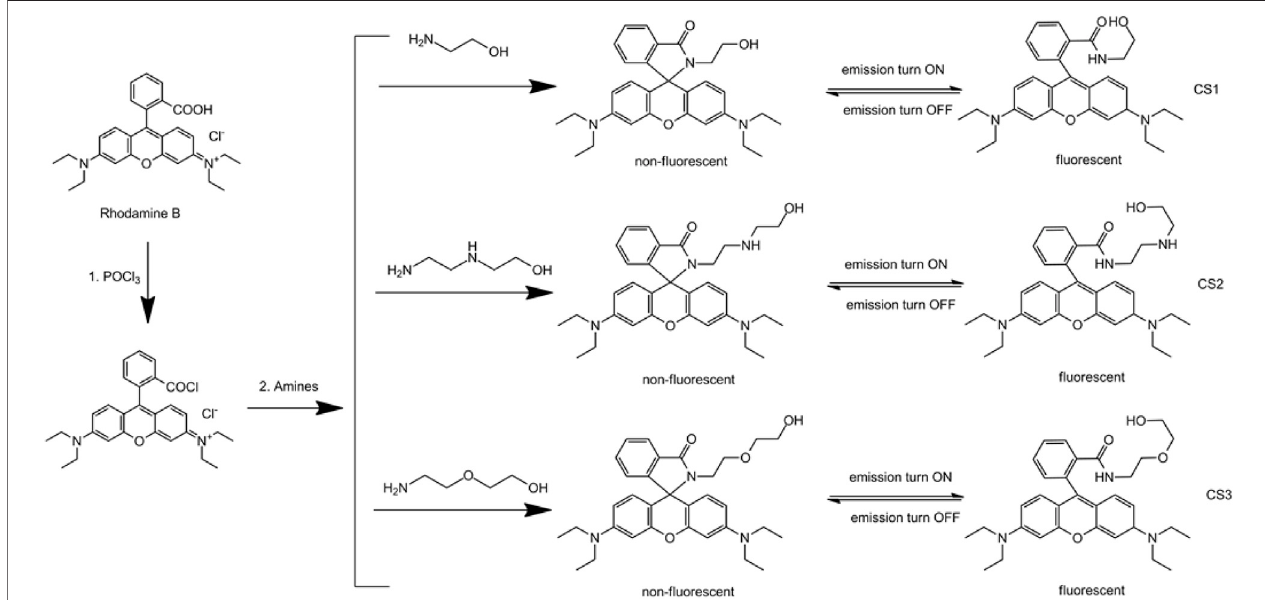
SCHEME 1 | Synthetic protocol for